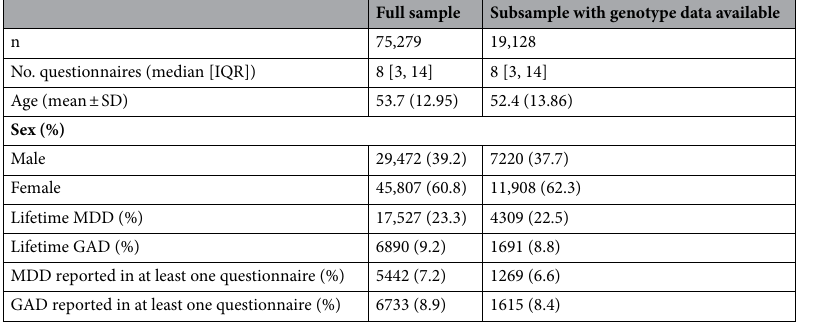
Table 1. Characteristics of study